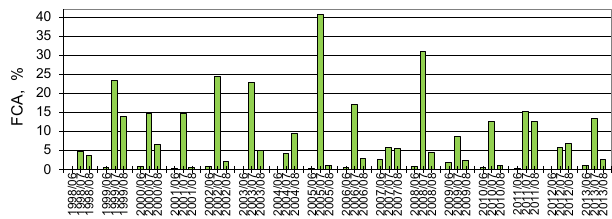
Figure 8. Comparison between ship transects of phycocyanin (PC) fluorescence (left panels) and satellite detection of cyanobacteria accumulations (right panels) in July 2010. Along-transect PC fluo- rescence (red, relative scale from 0–100) is shown together with the corresponding satellite mean score for accumulations in the 5 × 5 pixel window centered at the nearest pixel (black squares). Satel- lite maps show detected accumulations (black), valid areas with no detected accumulations (gray), missing data due to clouds (white) and the ship track (red line). (A, B) 3 July; (C, D) 10 July; (D, F) 12 July; (G, H) 20 July.